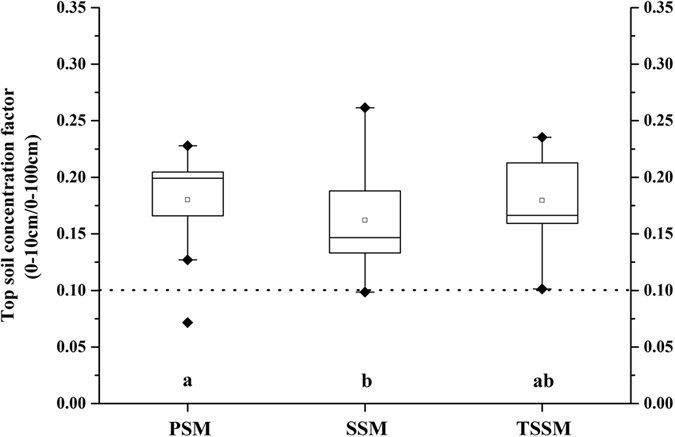
Topsoil concentration factors (TCFs, 0–10 cm/0–100 cm) of volumetric SOC values (SOCv, kg/m2) in the three salt marshes (abValues with different letters represent significant differences between different salt marshes, P < 0.05).